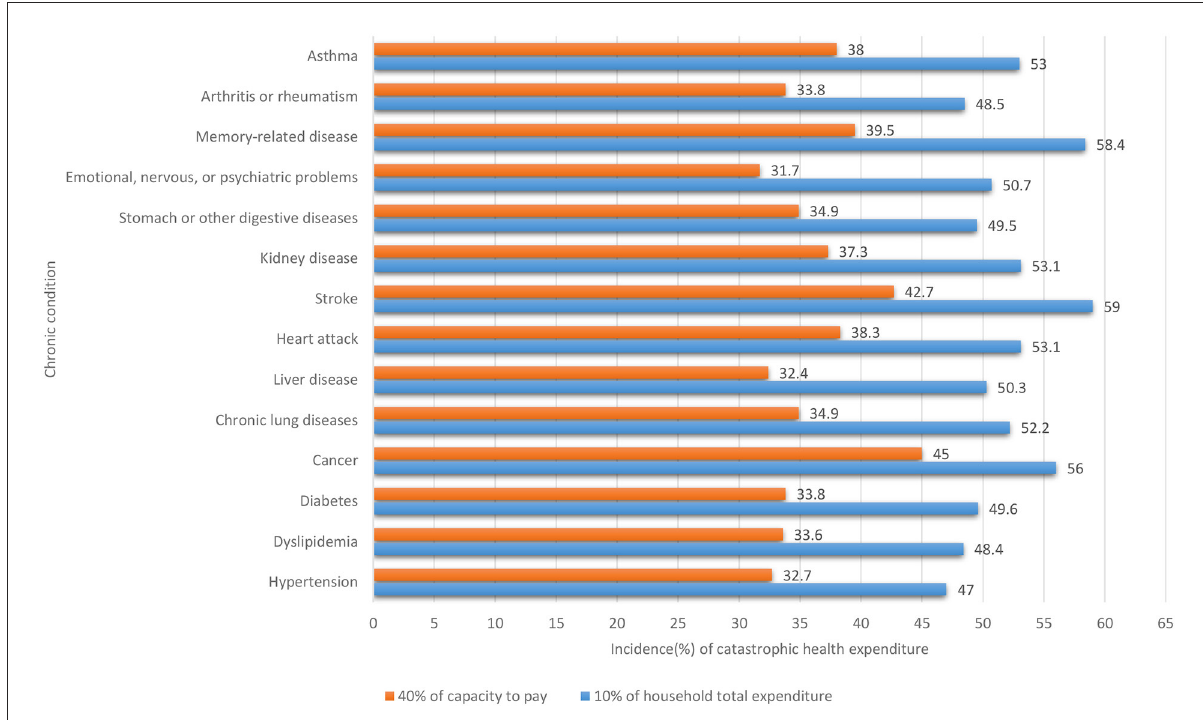
FIGURE1 Incidence of catastrophic health expenditure by chronic conditions reported by respondents ( n = 3511).